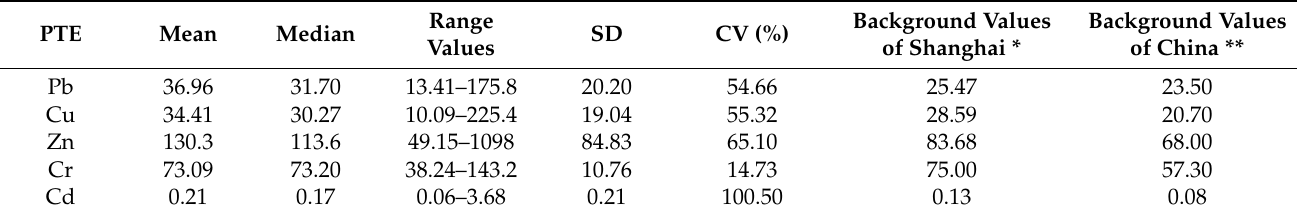
Table 1. Description statistics of PTE in urban green spaces soil (mg kg − 1